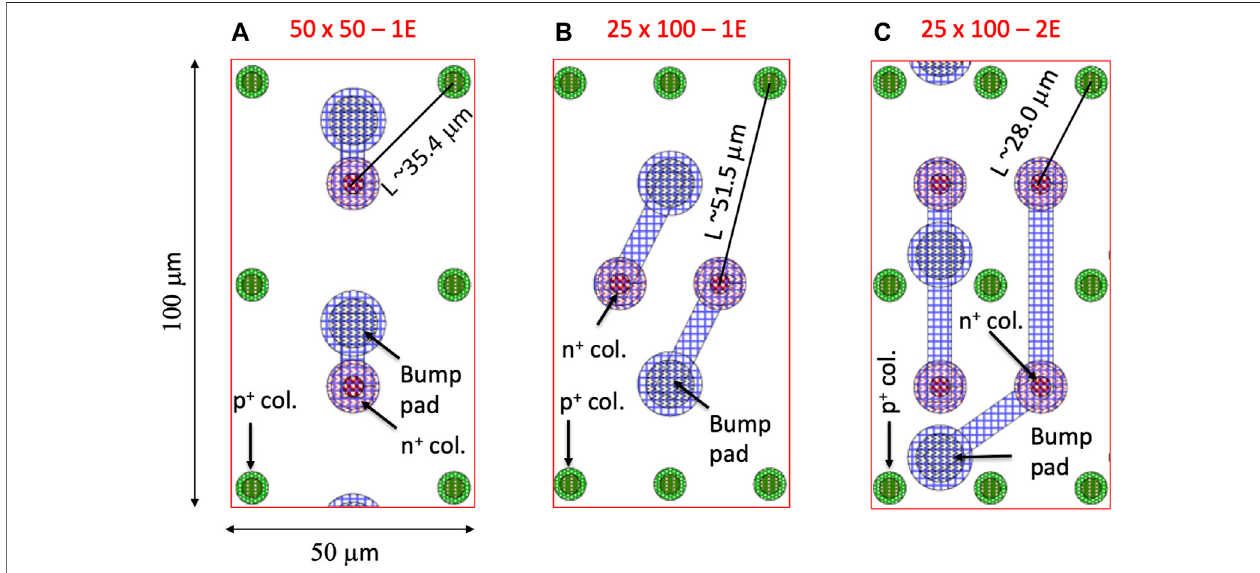
FIGURE 2 | Layouts of two adjacent small-pitch 3D pixels of different geometry for the ATLAS and CMS upgrades at HL-LHC: 50 μ m × 50 μ m-1E (A) , 25 μ m × 100 μ m-1E (B) and 25 μ m × 100 μ m-2E (C) .